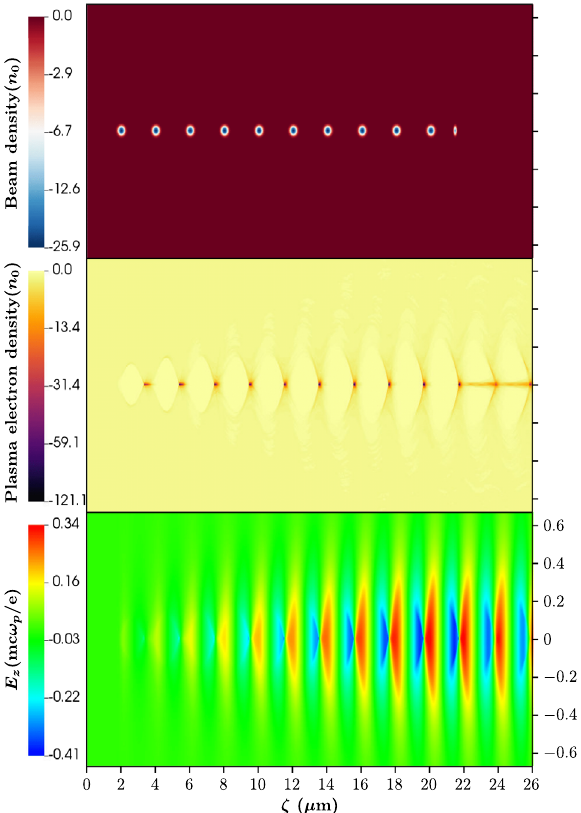
FIG. 1. PIC simulation snapshots of the beam charge density, plasma electron density, and longitudinal electric field for the ten bunches followed by a witness bunch (charge per driver bunch ¼ 0 . 32 pC).